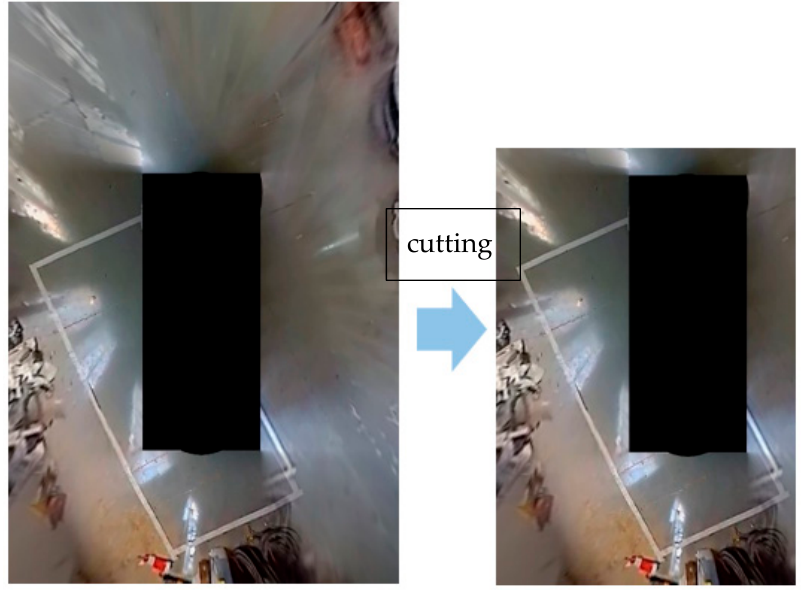
Figure 8. Cutting Figure 8. Cu tt ing area.